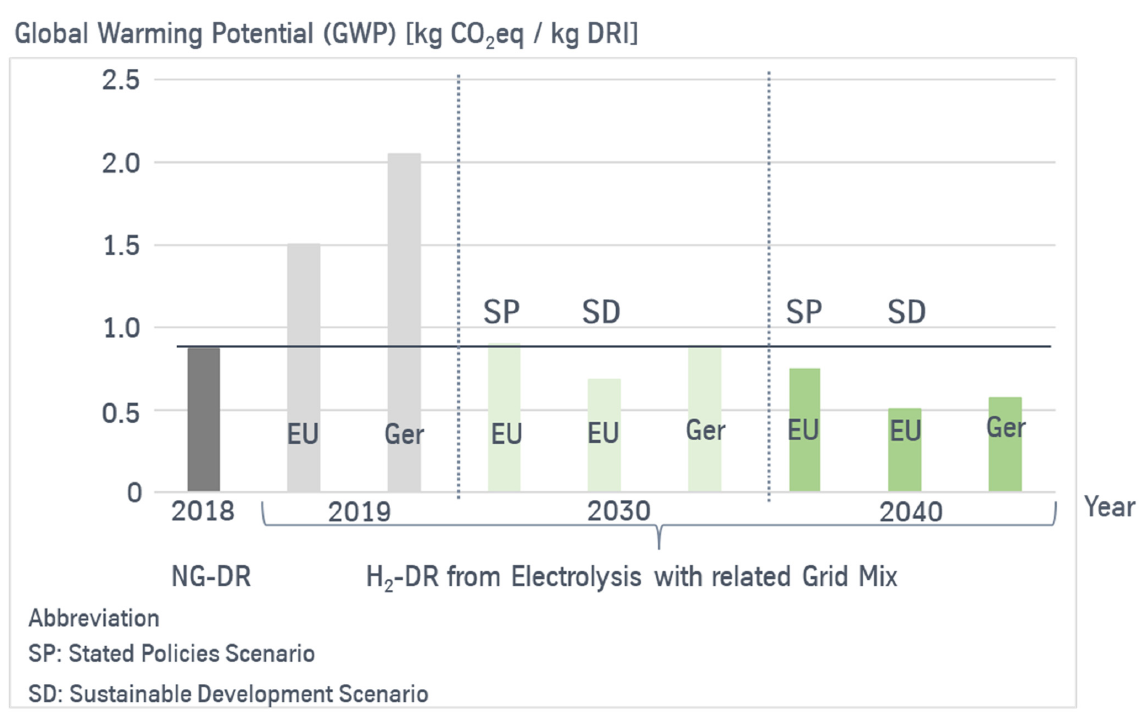
Figure 9. Development of the carbon footprint of direct reduced iron (DRI). For the European development, a stated policy scenario (SP) and a sustainable development scenario (SD) are considered, based on the IEA [34]. The German development scenario is based on Prognos et al. [35]. The carbon footprint of hydrogen in the scenarios are shown in Figure 4.